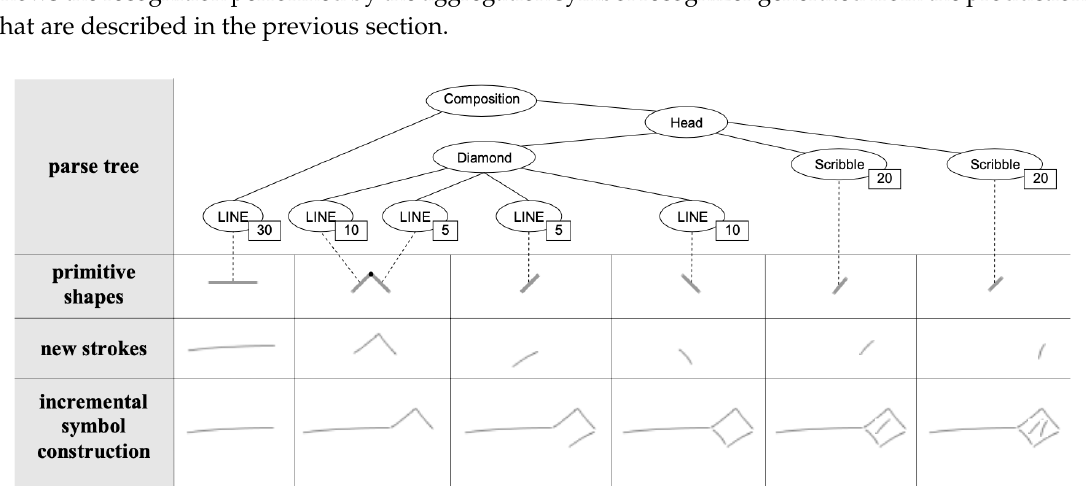
Figure 8. Incremental recognition of a Composition